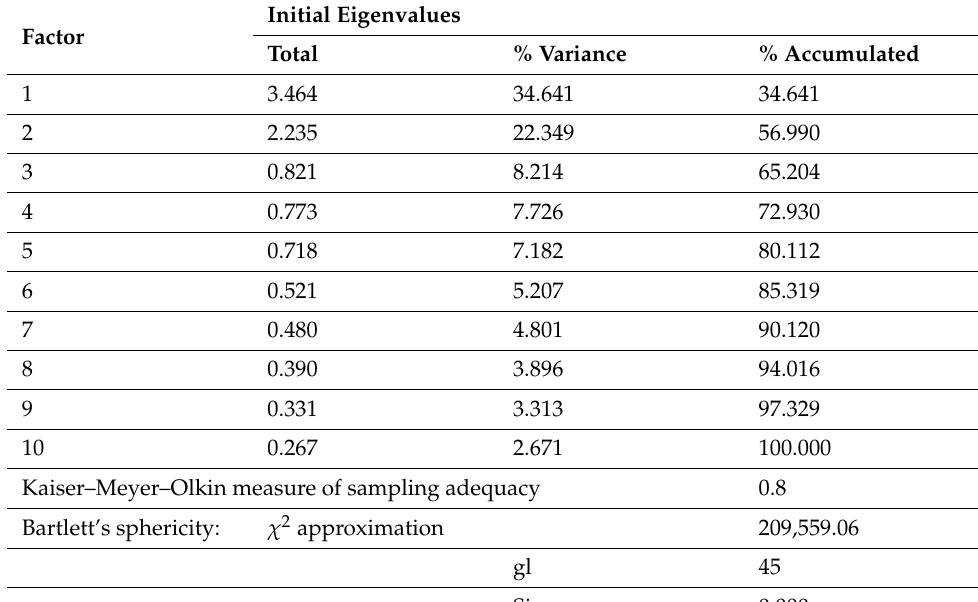
Table 3. Total explained variance and goodness-of-fit test in period